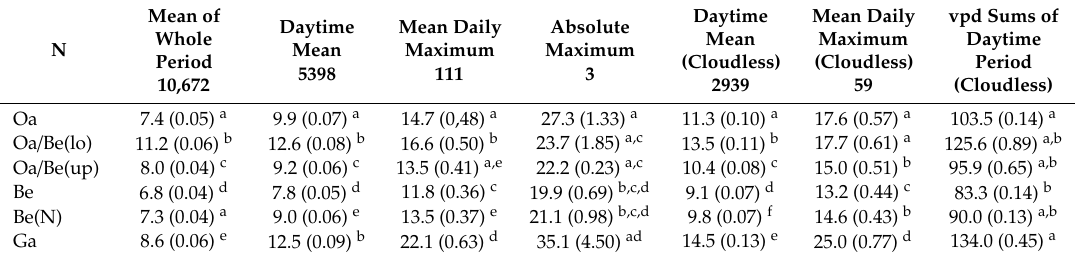
Table 5. Mean atmospheric saturation deficit (vpd, in hPa), mean daytime vpd, mean daily vpd maximum, mean absolute maximum vpd, and vpd sums (with SE in brackets) at the five measuring points in the forest and in the gap, averaged over the three transects. The daytime period refers to 9 a.m.–9 p.m. Significantly di ff erent means are marked with di ff erent small letters. The first four columns refer to all days of the measuring period, the last two columns only to days with less than 50% cloudiness and no rain (cloudless). N gives the number of individual 15-min values used for averaging. The vpd sums given in the last column were calculated by adding the 15-min values of 19 cloudless days (unit: MPa).